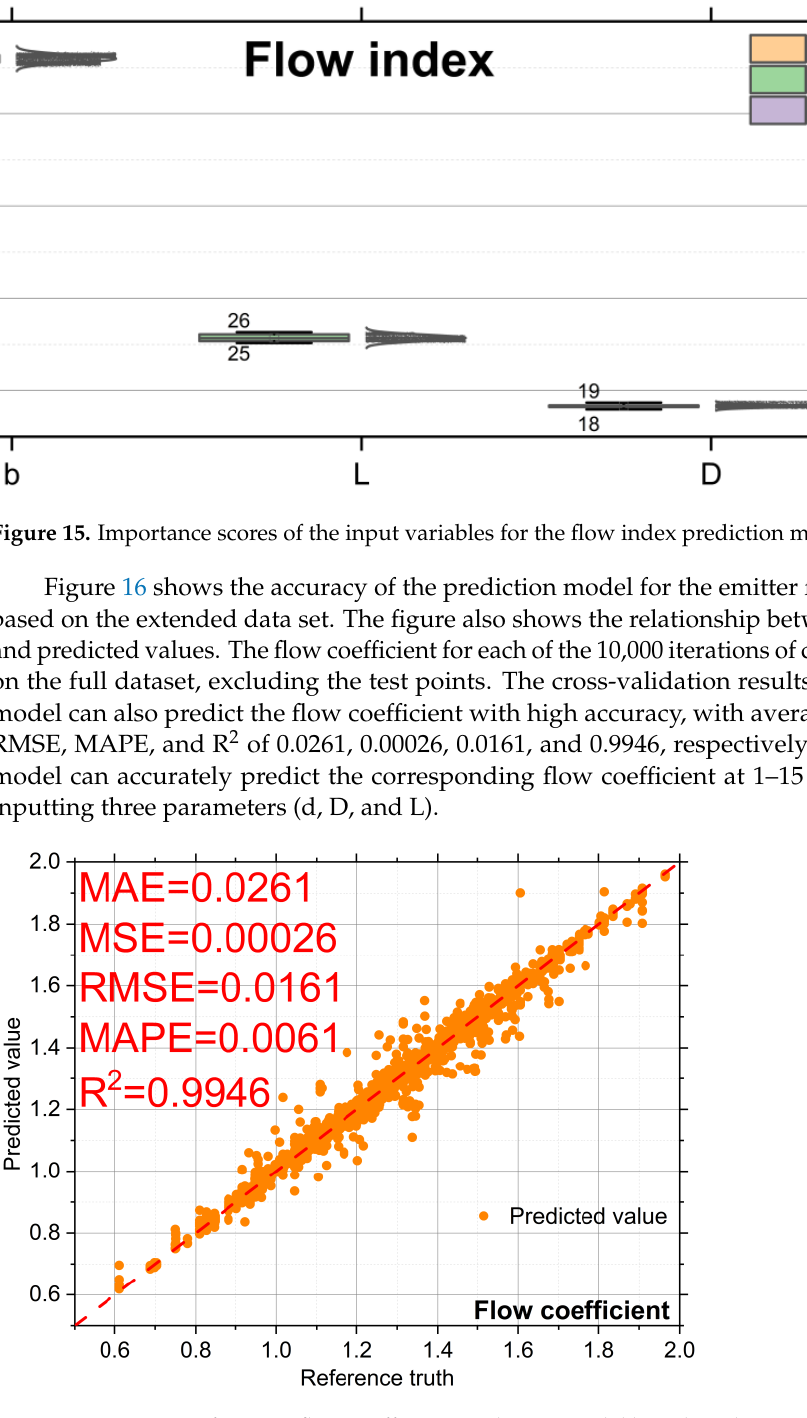
Figure 17. Importance score of the input variables for the prediction model of the emitter flow coef- ficient.